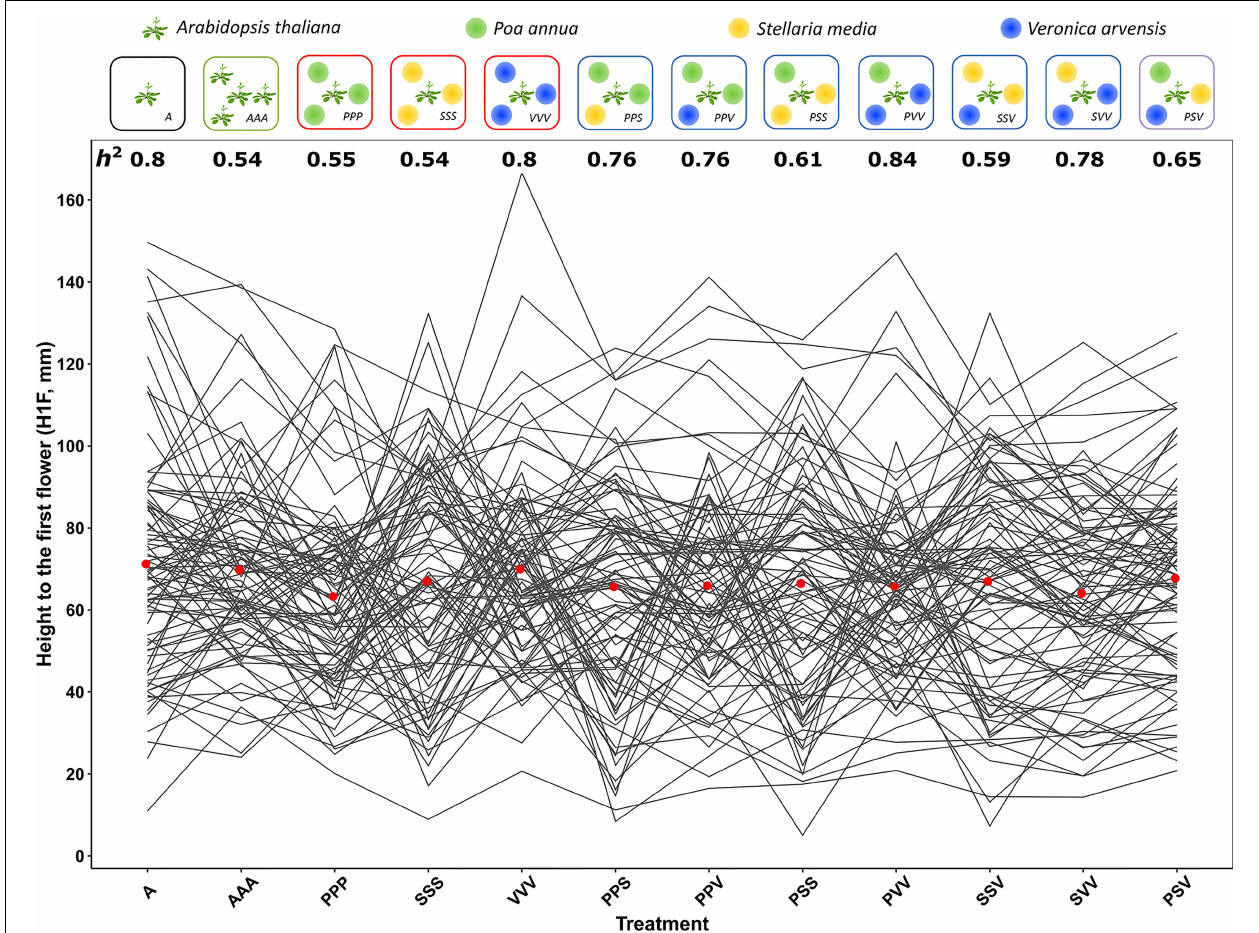
FIGURE 1 | Natural genetic variation of reactions norms of 89 TOU-A accessions across 12 plant–plant interaction treatments. (Top panel) Diagram illustrating the 12 treatments. (Bottom panel) Height from the soil to the first flower on Arabidopsis thaliana (H1F). Each line links the genotypic values of one of 89 TOU-A accessions. The two remaining accessions A1-69 and A1-117 are not represented due to the missing genotypic values in the PPV and SSS treatments, respectively. For a given treatment, the mean H1F genotypic value among the accessions is represented by a red dot. h 2 : narrow-sense heritability